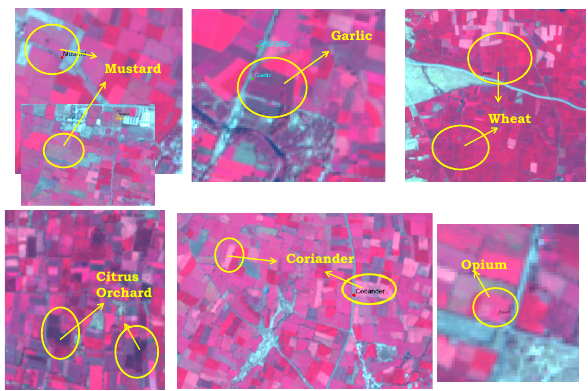
Figure 5. Tonal Variations of Different Competing Crops.